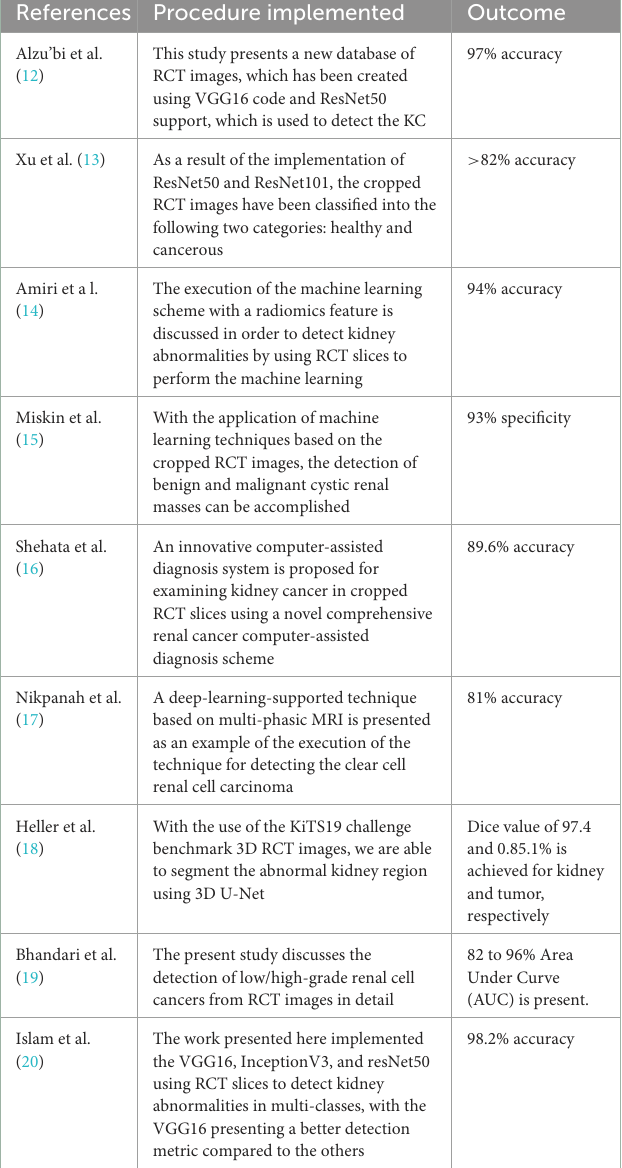
TABLE 1 Summary of the renal CT image examination